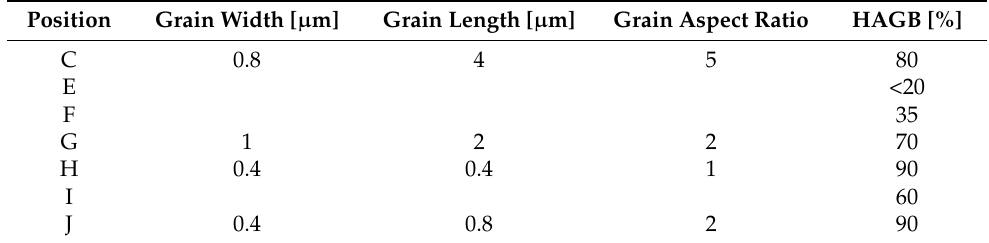
Table 2. Microstructural parameters (grain width and length, grain aspect ratio, and percentage of HAGBs evaluated from the OIMs in Figure 3) taken from positions denoted in Figure 2. Position Grain Width [ µ m] Grain Length [ µ m] Grain Aspect Ratio HAGB [%] C